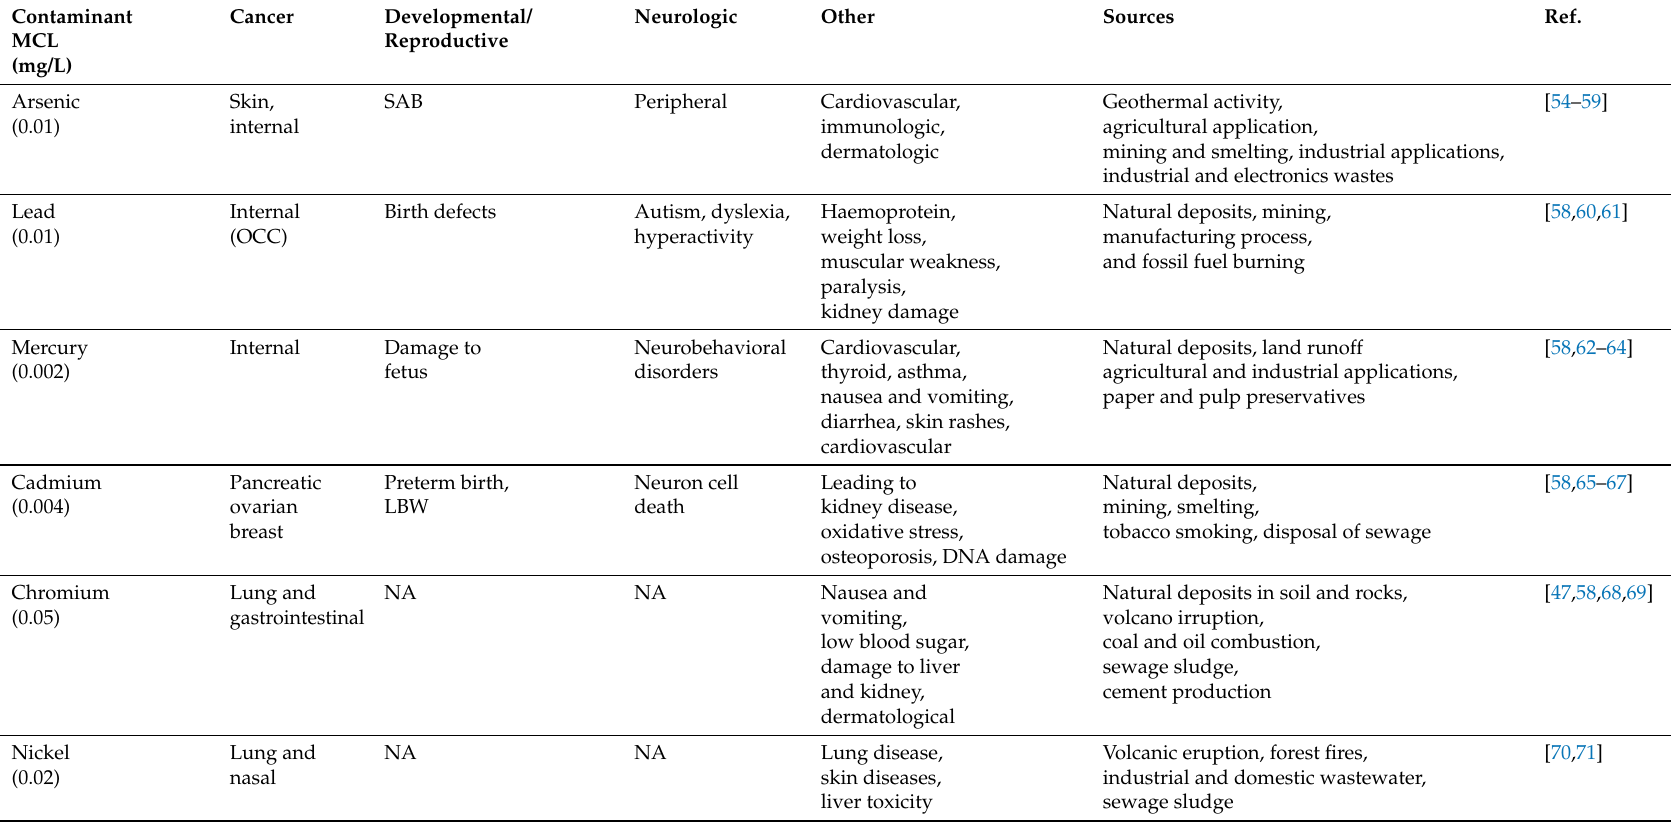
Table 1. Contaminants and their potential health